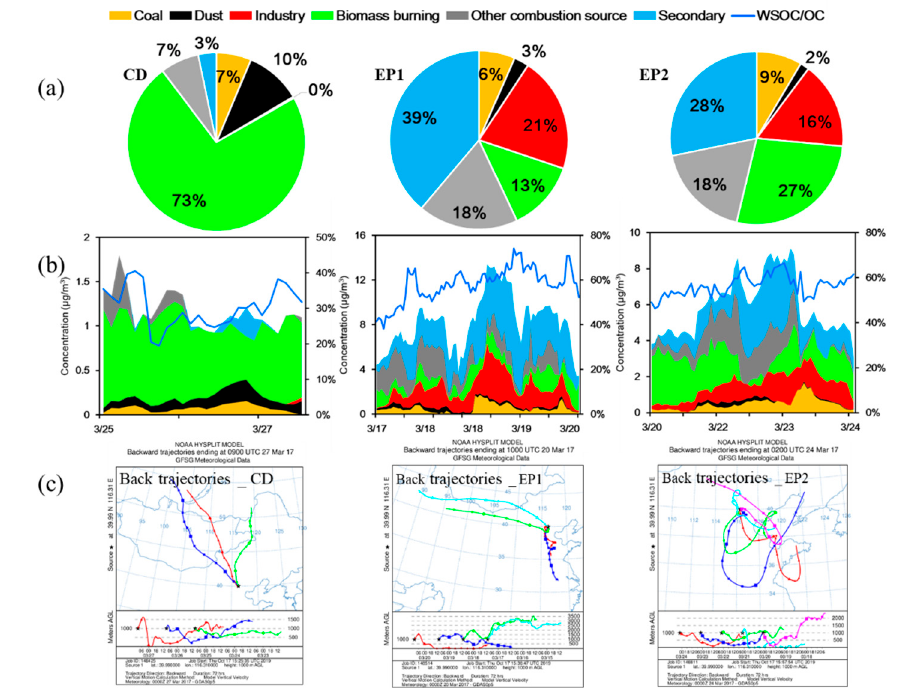
Figure 4. Source contribution to the observed WSOC during clean days (CD) and pollution episodes (EP) based on PMF model: ( a ) average source contribution, ( b ) temporal variation of different source contributions and the WSOC/OC ratio (blue line, in percentage), and ( c ) 72-h backward air mass trajectories.